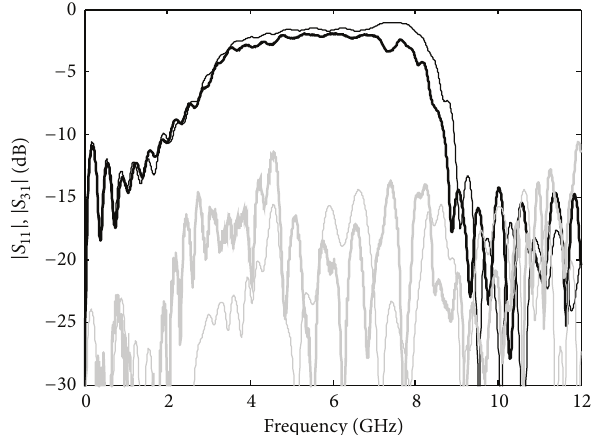
Figure 6: Simulations (thin line), and measurements (thick line) of | (grey line) and |𝑆 | (black line) in the dispersive delay line of |𝑆 11 31 Figure 5.